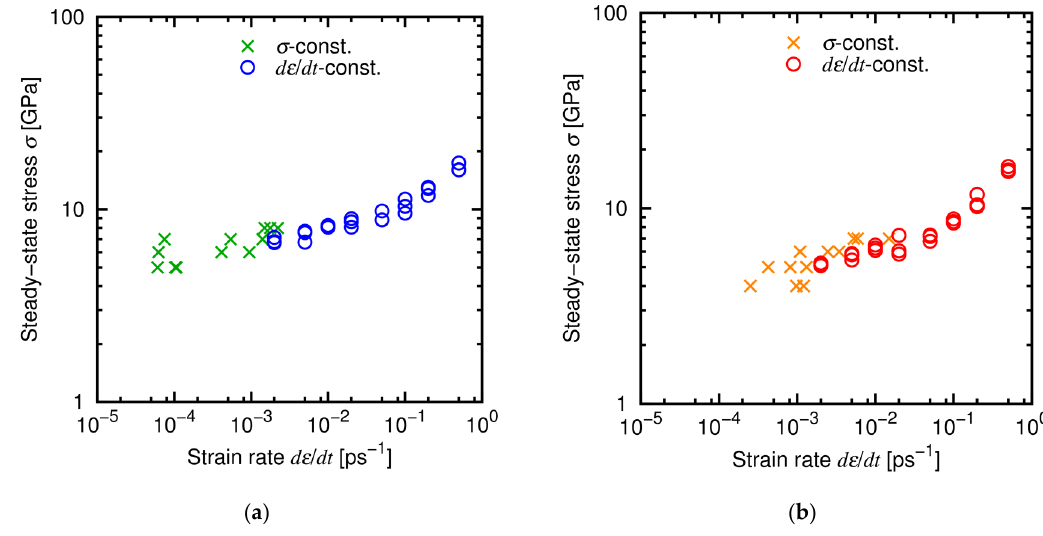
Figure 12. Relationship between the steady-state stress and the strain rate obtained under the σ - and d ε / dt -constant conditions at ( a ) 1000 K and ( b ) 1500 K.